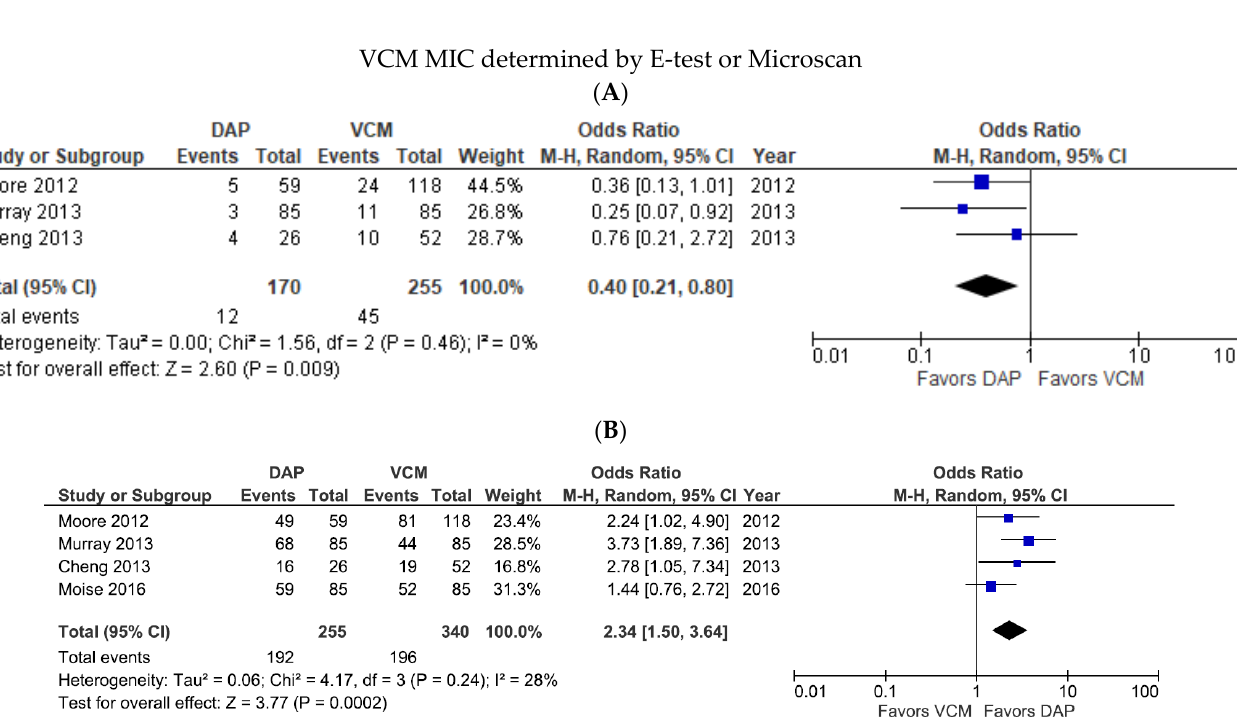
Figure 4. Forest plots of the mortality and treatment success rates of patients treated with DAP versus VCM for bacteremia caused by MRSA with VCM MIC > 1 µg/mL, according to the MIC test method. ( A , B ) Forest plots of the mortality rate ( A ) and treatment success rate ( B ) of DAP versus VCM when the VCM MIC was determined by E-test or Microscan. Symbols and abbreviations are as described in Figure 2.